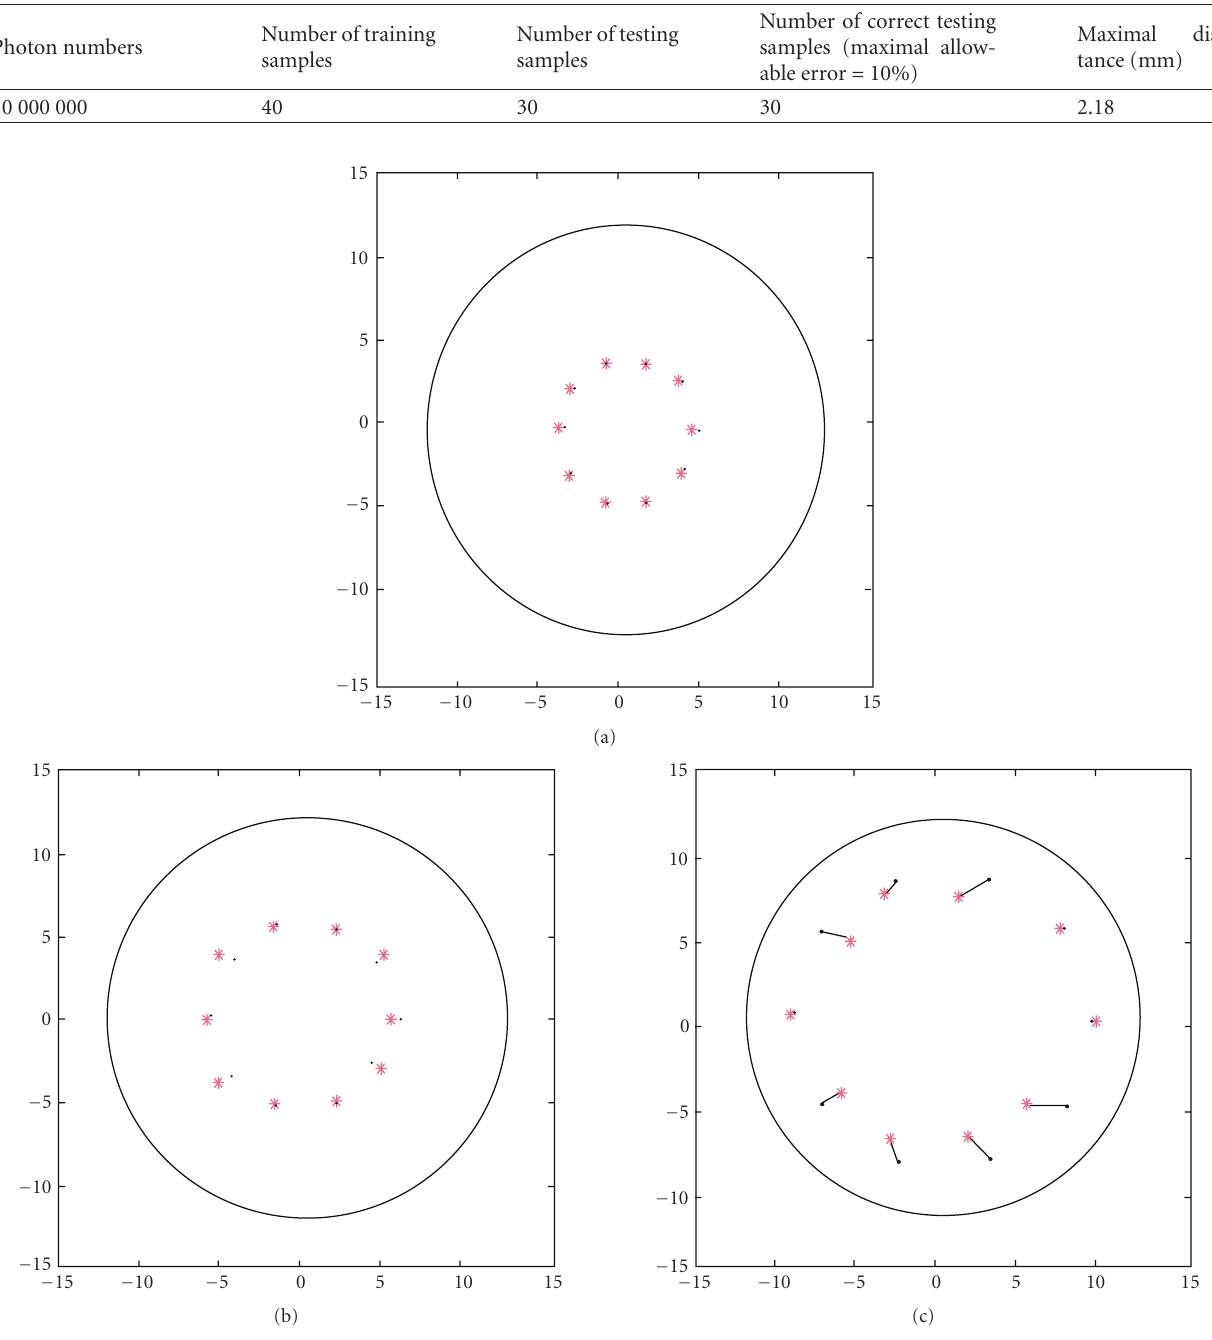
Table 1: Estimation of source position on the z -plane of z = 6.